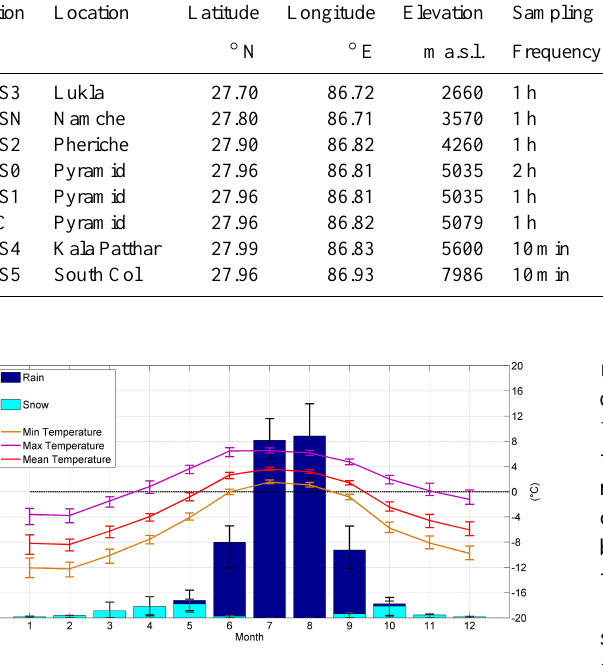
Figure 2. Mean monthly cumulated precipitation subdivided into snowfall and rainfall and minimum, maximum, and mean tempera- ture at 5050ma.s.l. (reference period 1994–2013). The bars repre- sent the standard